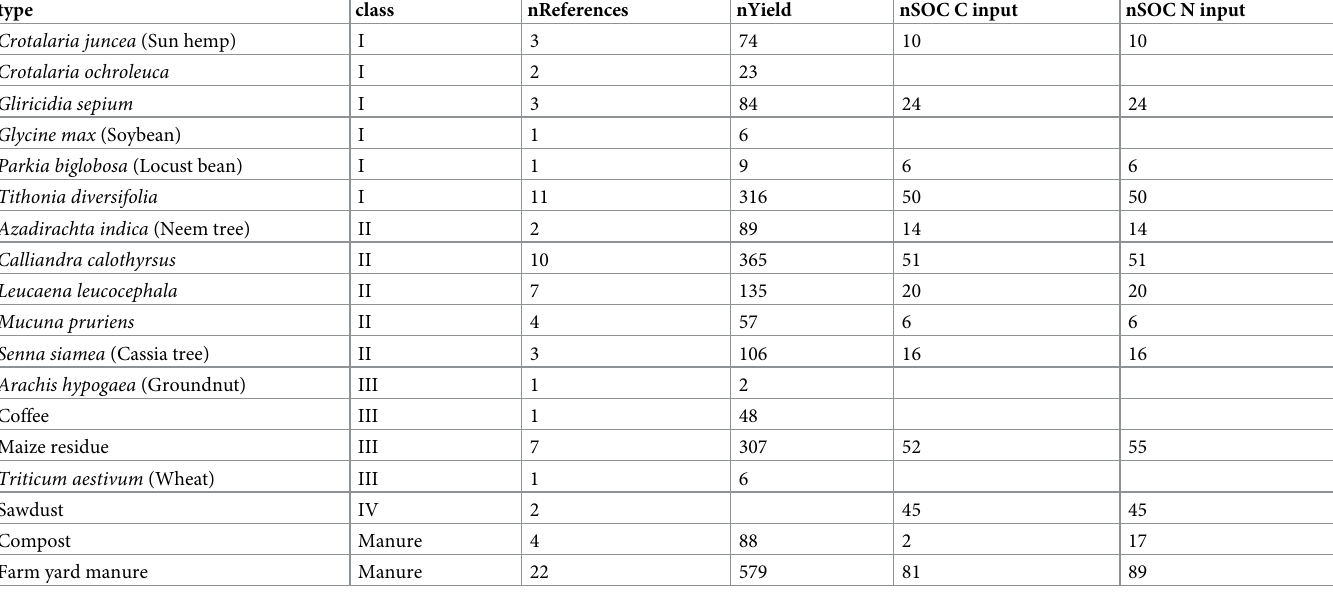
measurements over time were reported, so that responses could be calculated by subtracting the initial SOC from the SOC at a given time during or after the experiment (dSOC). Finally, soil and climate data were not sufficiently reported and therefore not included in the analysis. See Table 1 for a complete overview of the data. Table 2. List of organic resource types and associated quality classes, with columns for the respective number of studies (nReferences), number of yield data (nYield), and number of SOC data with C and N rates different from zero (nSOC C input and N input, respectively).